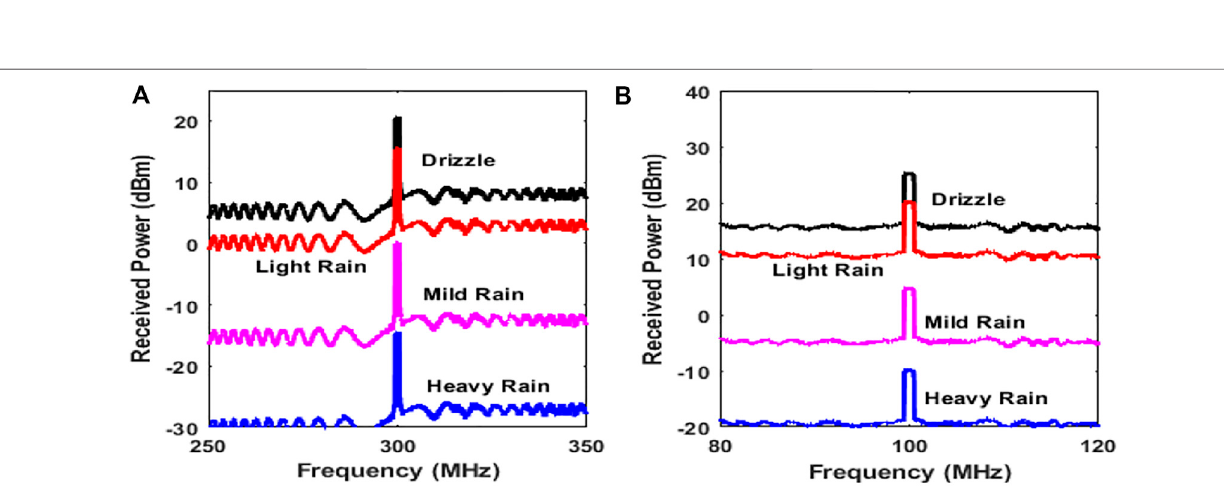
Frontiers in Physics |